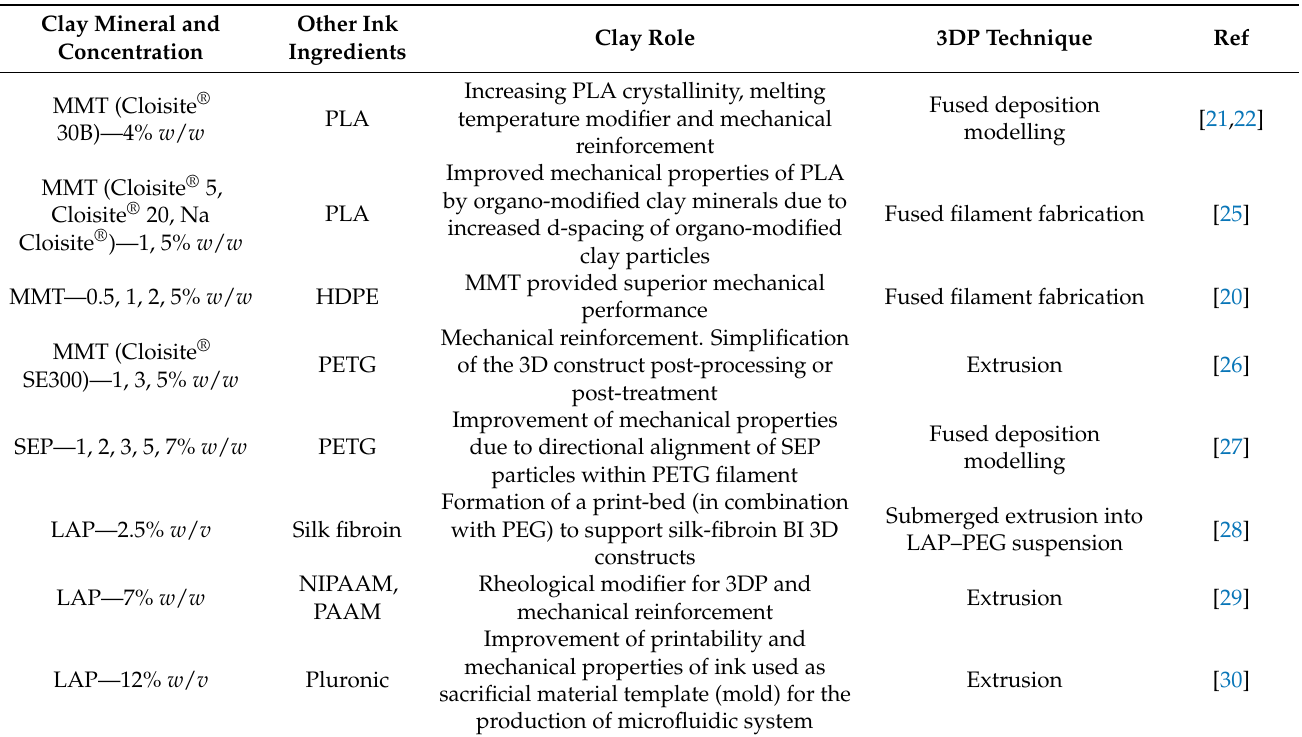
Table 2. Clay minerals in 3DP technology with potential applications in medicine and